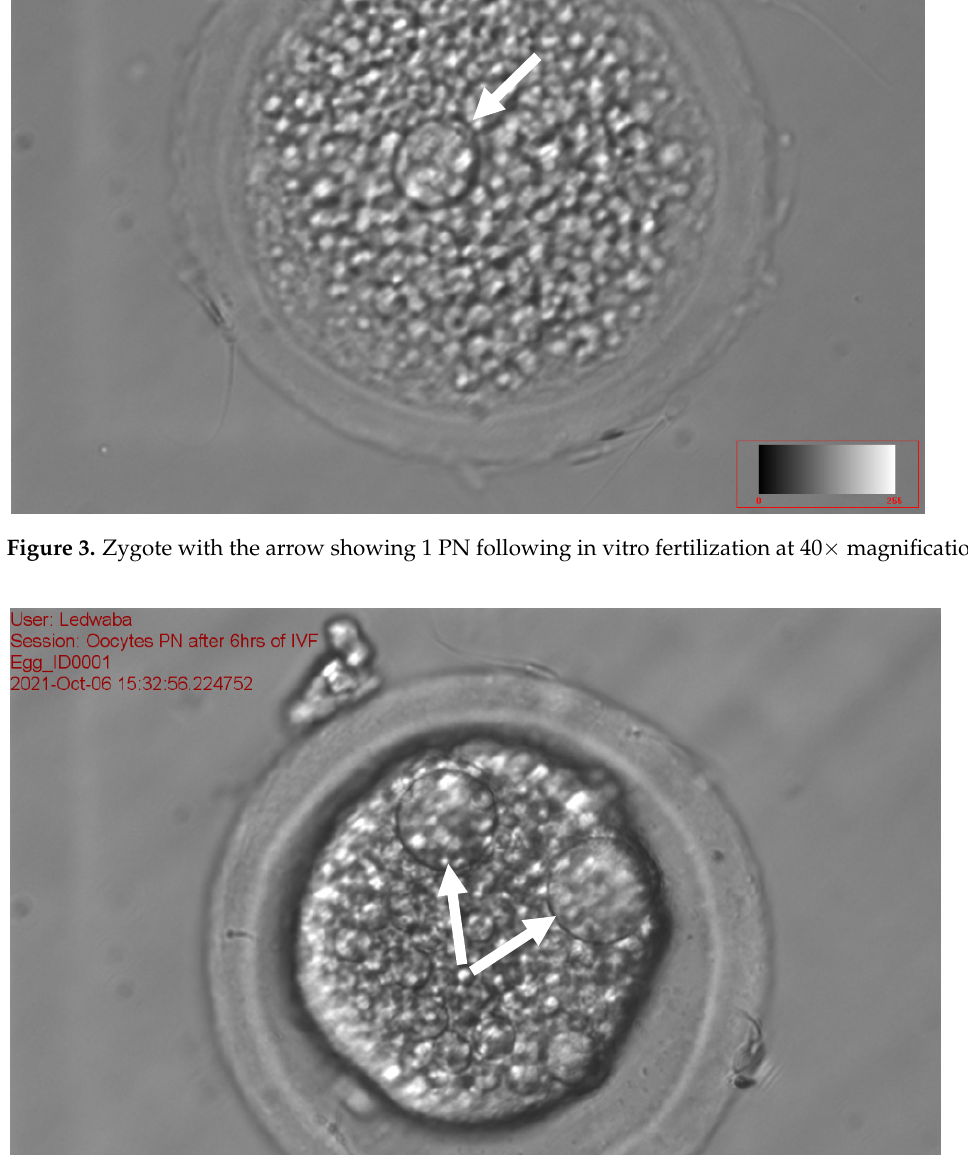
Figure 5. Zygote with the arrows showing >2 PN following in vitro fertilization at 40× magnifica- tion.